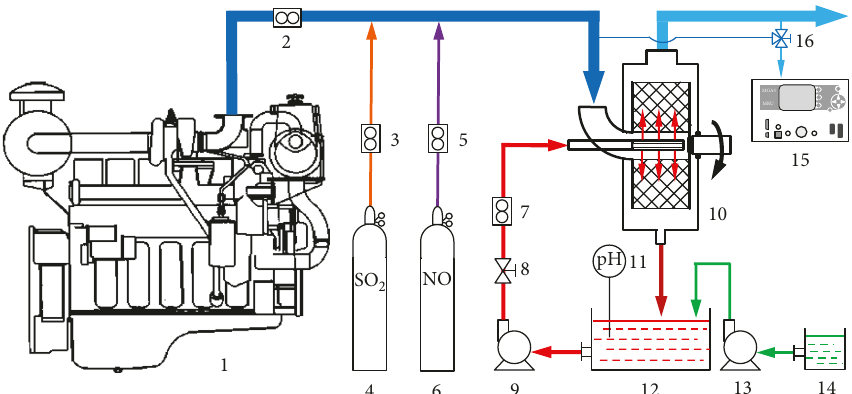
2 cylinder; 6: NO cylinder; 7: